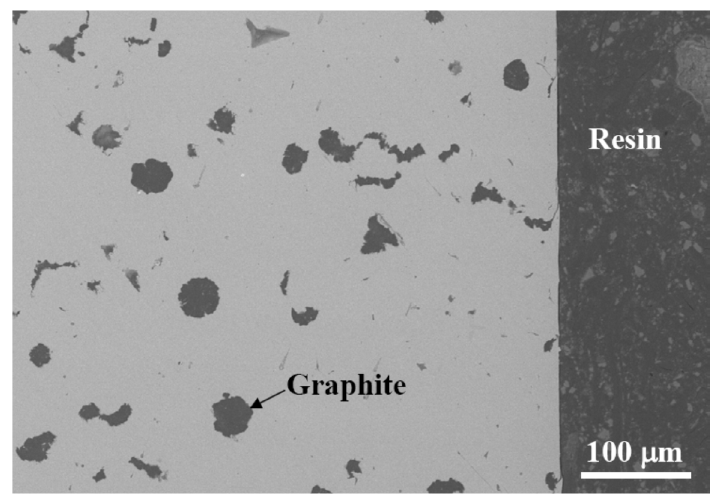
Figure 1. SEM cross-section of the ductile cast iron used in the study.